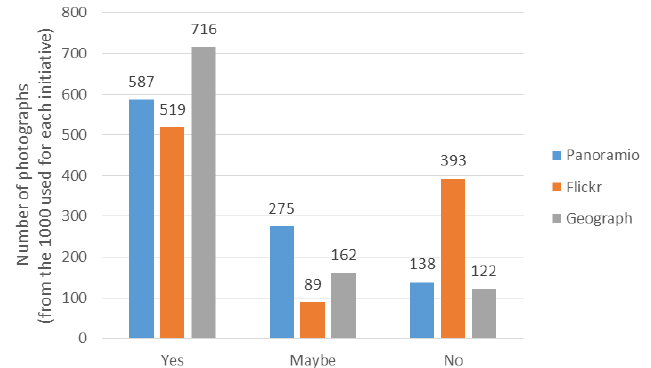
Figure 5. Mean number of photographs assigned to the classes “Yes”, “Maybe” and “No” by the five volunteers.